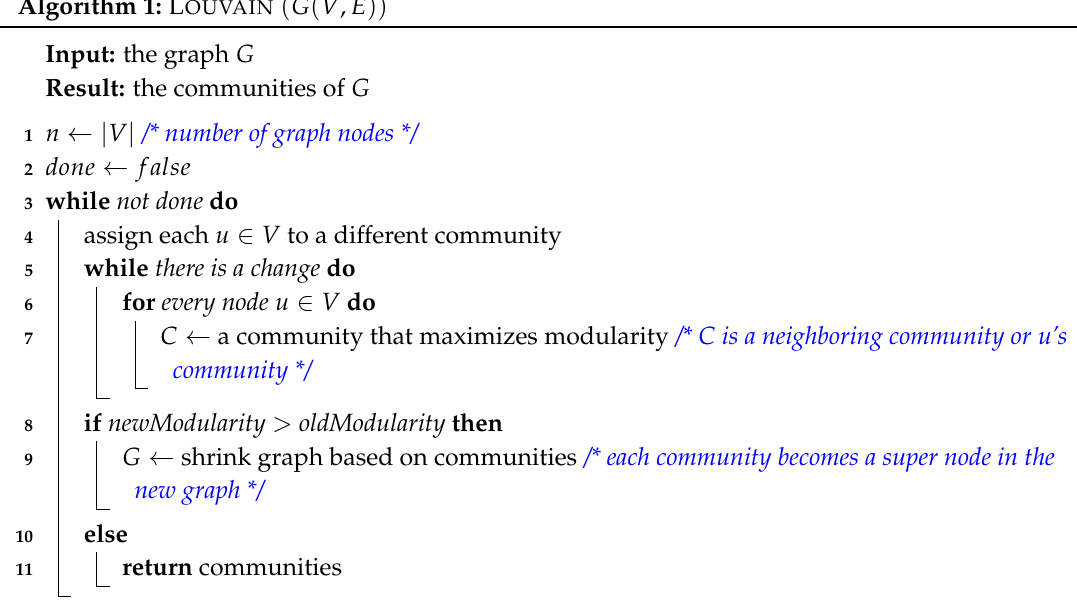
Algorithm 1: L OUVAIN ( G ( V , E